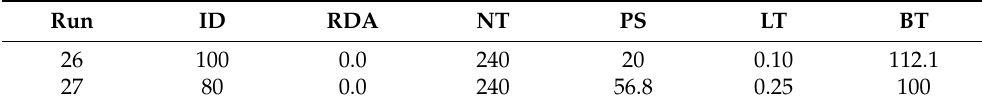
Table 8. Control parameters for the confirmation runs.